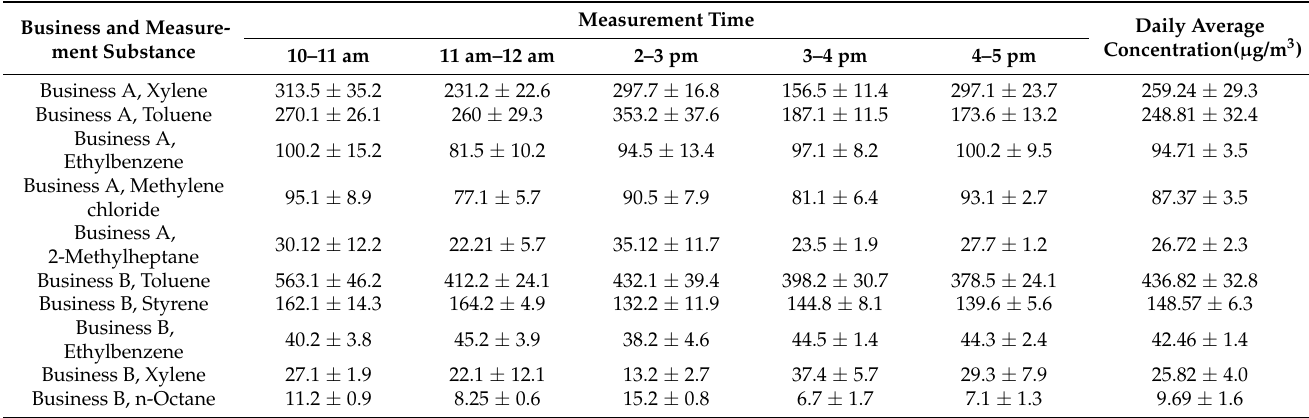
Table 7. VOC speciation concentration by businesses A and B.